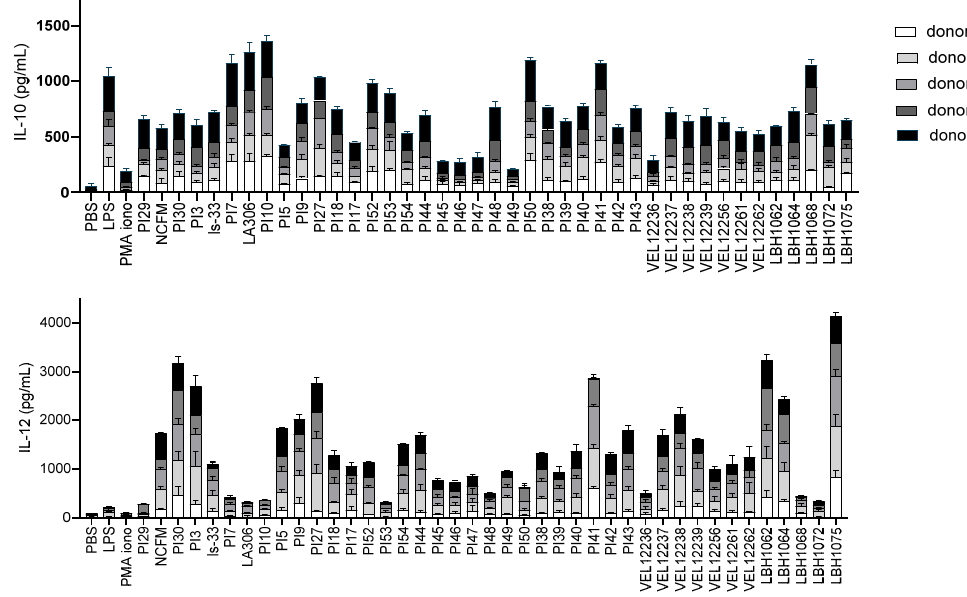
Figure 4. Immunomodulation of PBMCs. Strains were co-incubated with PBMCs from 5 donors. IL-10 and IL-12 were dosed in the supernatants (productions from each donor are stacked on the graph). Each strain was tested with 3 independent cultures (3 biological replicates) in technical triplicates. Data are shown as mean ± SEM.